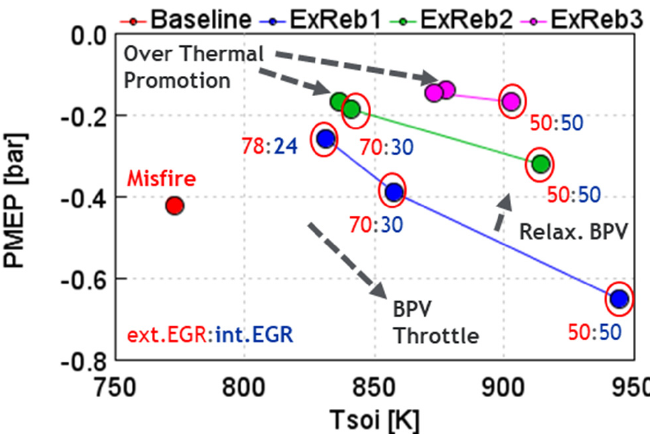
Figure 15. PMEP versus Tsoi trends among the ExReb1, ExReb2, and ExReb3 strategies. The challenge of int.EGR portion control associated with the larger rebreathe events would likely lead to thermal overpromotion of the in-cylinder charge mixture that poten- tially risks breaching the maximum pressure rise rate (MPRR) limit (refer to Table 3) and incurring higher heat transfer losses (refer to Table 4) during combustion. Furthermore, the challenge of internal residual gas control for the ExReb2 and ExReb3 strategies would likely result in a higher cylinder-to-cylinder residual gas imbalance (shown in Appendix Figure A1). Therefore, ExReb1 (36% of the main peak lift) was determined to be the most appro- priate rebreathe lift profile compared to ExReb2 and ExReb3. 5.3.2. Rebreathe Profile Location Optimization Fundamentally, to facilitate exhaust rebreathing, a large pressure difference between the exhaust port and the cylinder pressure is desirable. Therefore, the inducted residual mass and the PMEP levels are expected to be sensitive to the rebreathe profile location. For an optimized rebreathe profile location, simulations were conducted where the ExReb1 profile was advanced and retarded by the 50 CAD from its current location of the center of the intake valve duration. For an accurate profile location impact, the turbine rack and the BPV positions were fixed (refer to Table 5). Figures 16a–c compares the exhaust port and cylinder pressure traces for the ExReb1 locations at the advanced 50 CAD, the center of the intake valve, and the retarded 50 CAD, respectively. The piston velocity traces were also plotted for reference. For the center lo- cation (Figure 16b), the rebreathe event appeared synchronized with the piston velocity where the peak lift of the rebreathe valve occurred near the maximum piston velocity. The maximum piston velocity led to an appreciable pressure difference between the cylinder and exhaust port by reducing the cylinder pressure, as observed in Figure 16b. In contrast, for the advanced 50 CAD (Figure 16a) and the retarded 50 CAD (Figure 16c) locations, the piston velocity appeared to be reduced by ~50% from its peak level, thereby generating a relatively smaller pressure difference between the cylinder and the exhaust port.